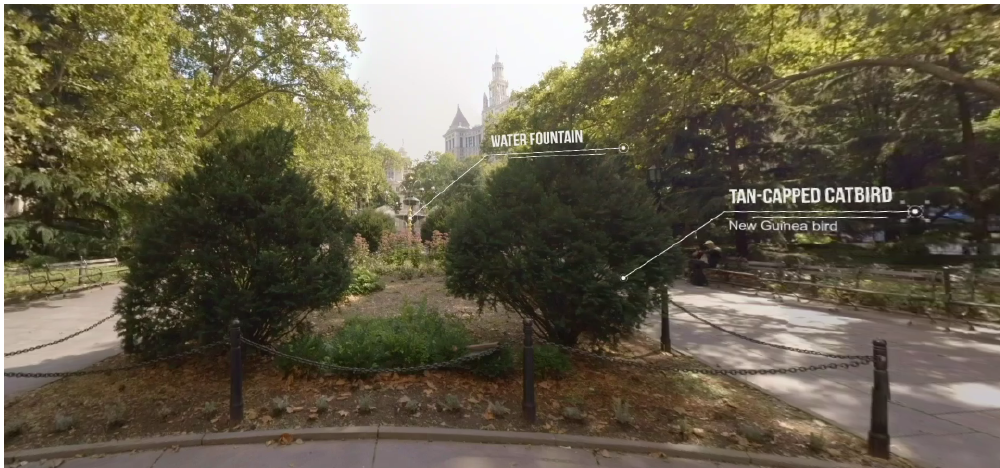
Figure 4. Screenshot of the demonstration by team Noize Makers, using 3D legend objects that point towards the location of the localized sound objects.